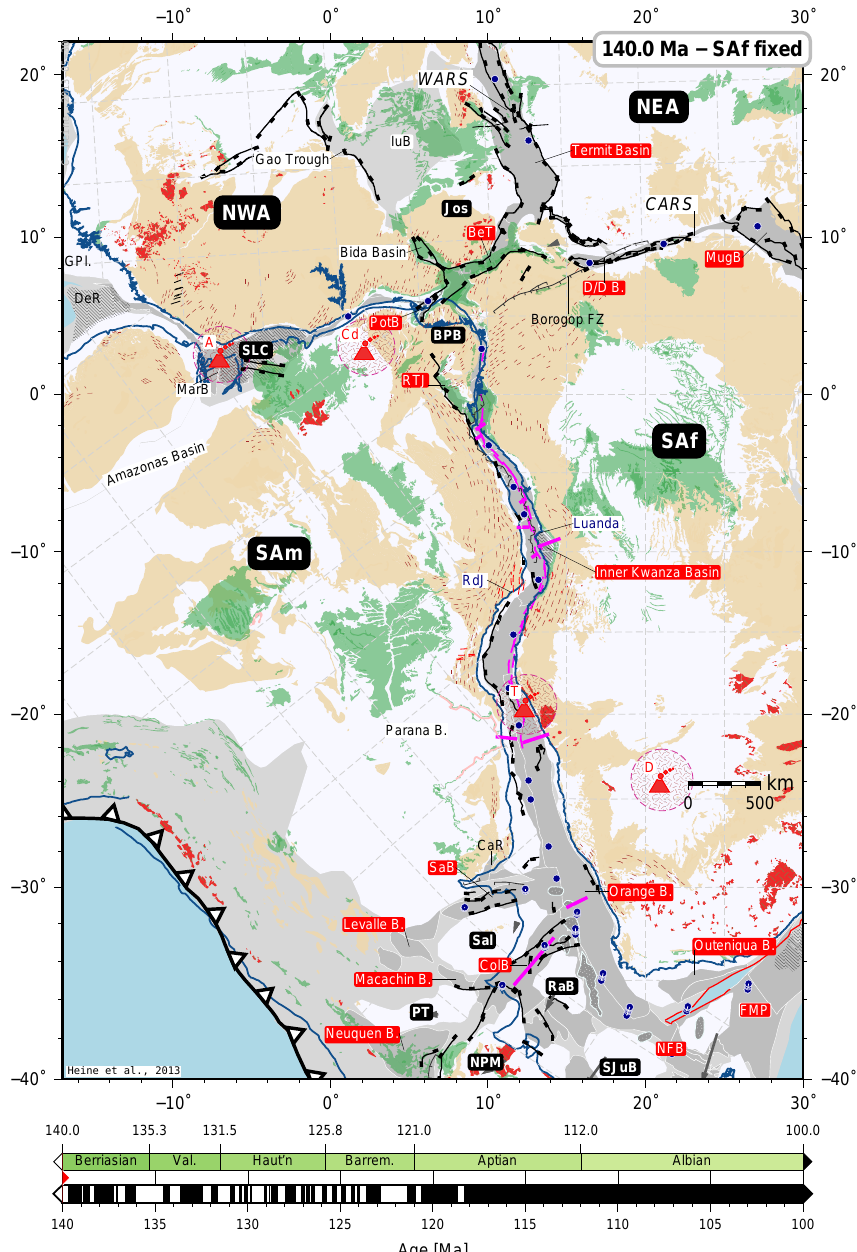
Fig. 13. Plate tectonic reconstruction at 140Ma, Africa fixed in present-day coordinates. For map legend see Fig. 22; bottom colour scales indicate geological stages and magnetic reversals with red diamond indicating time of reconstruction; abbreviations here: T – Tithonian; Val. – Valaginian; Haut’n – Hauterivian; Barrem. – Barremian. Restored continental margin is indicated by dashed magenta-coloured line, restored profiles (Fig. 4) by solid magenta lines. Rigid lithospheric blocks denoted by black labels: SAf – austral African Plate, BoP – NE Brazilian Borborema Province plate; Jos – Jos Plateau sub-plate; NEA – NE African Plate; NPM – North Patagonian Massif; PT – Pampean Terrane; RaB – Rawson Block; Sal – Salado Sub-plate; SAm – main South American Plate; SJuB – San Julian Block; SLC – S˜ao Luis Craton block. Actively extending basins are indicated by red background in label; post-rift basins are indicated by light grey background in label; abbreviations: BeT – Benue Trough; CaR – Canelones rift; D/D B. – Doba and Doseo basins; ColB – Colorado Basin; IuB – Iullemmeden Basin; marB – Maraj´o Basin; MugB – Muglad Basin; NFB – North Falkland Basin; PotB – Potiguar Basin; TRJ – Reconavo, Jatoba and Tucano basins; SaB – Salado Basin. Other abbreviations: RdJ – Rio de Janeiro; B. – basin; GPl. – Guyana Plateau; DeR – Demerara Rise. Present-day hotspots are shown as volcano symbol and plotted with 400km diameter (dashed magenta-coloured circle with hachured fill), assuming that they are stationary over time: A – Ascension; B – Bouvet; Ch – Chad/Tibesti; Ca – Mount Cameroon; Cd – Cardno Seamount; D – Discovery; T – Tristan da